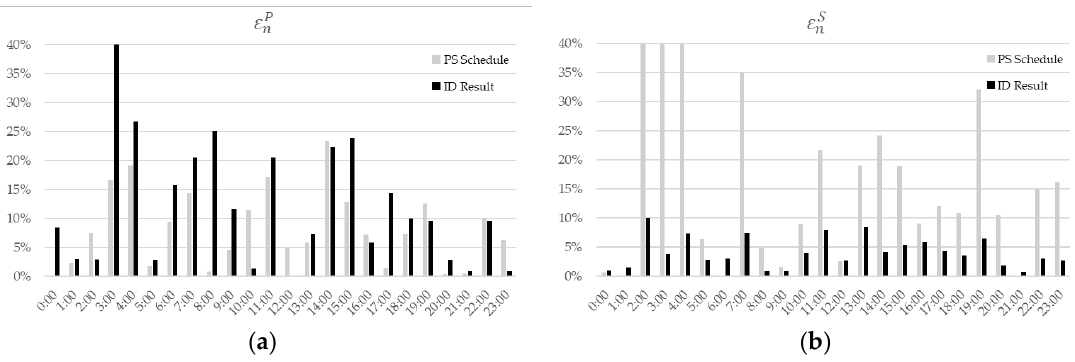
Figure 11. Bid ( 𝑃 𝑏𝑖𝑑 ), result of ID operation scheduling method ( 𝑃 𝑛𝑒𝑡 ) and generation with PS schedule ( 𝑃 𝑛𝑒𝑡,𝑃𝑆 ). Figure 11. Bid ( (cid:1842) (cid:3029)(cid:3036)(cid:3031) ), result of ID operation scheduling method ( (cid:1842) (cid:3041)(cid:3032)(cid:3047) ) and generation with PS Figure 11. Bid ( P bid ), result of ID operation scheduling method ( P net ) and generation with PS schedule ( P net , PS ). Figure 11. Bid ( (cid:1842) (cid:3029)(cid:3036)(cid:3031) ), result of ID operation scheduling method ( (cid:1842) (cid:3041)(cid:3032)(cid:3047) ) and generation with PS schedule ( (cid:1842) (cid:3041)(cid:3032)(cid:3047),(cid:3017)(cid:3020) ). schedule ( (cid:1842) (cid:3041)(cid:3032)(cid:3047),(cid:3017)(cid:3020) ).